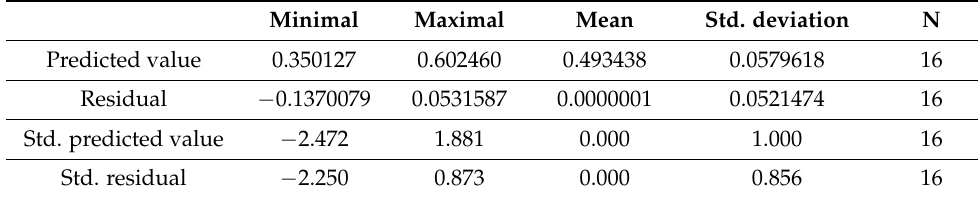
Table 6. Statistics- residuals with four predictors.